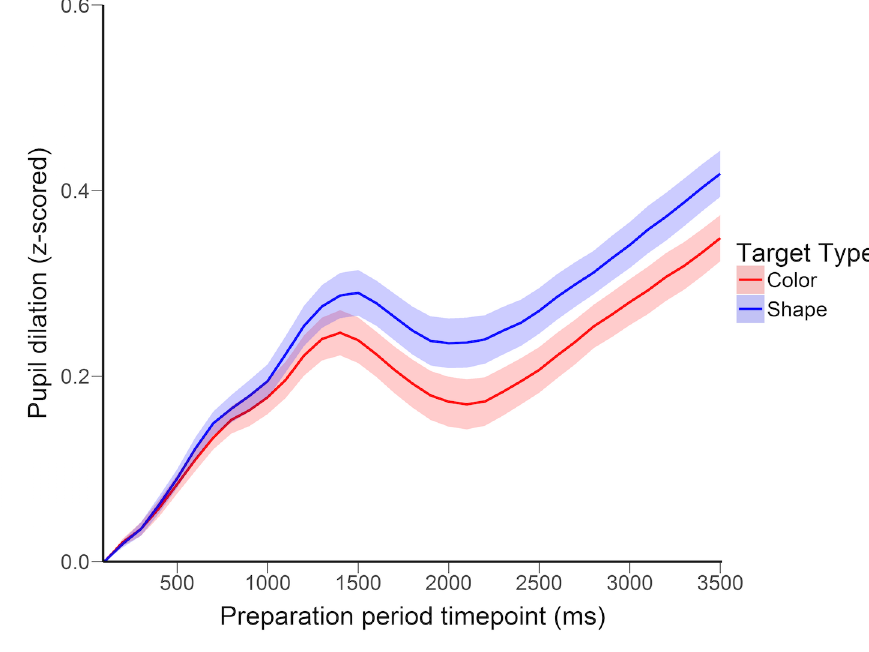
Fig 2. Pupil dilation across the preparation period in Experiment 1. Pupil dilationwas calculatedusing z- scored pupil area values. Error bandsdepict standarderror of the mean color vs shape difference scores.